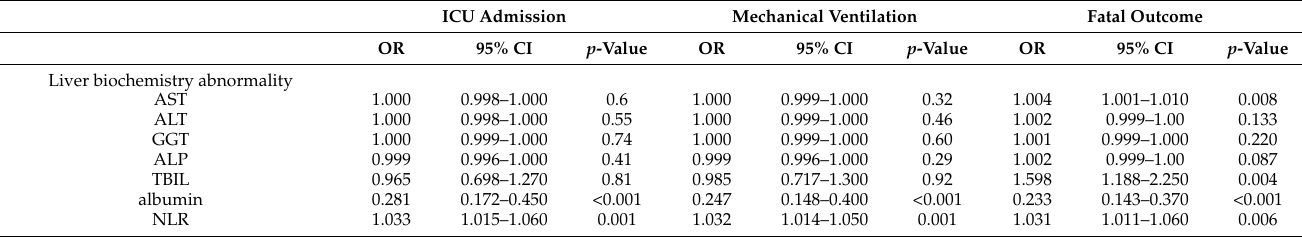
Table 3. The role of liver-related laboratory parameters in models containing potential risk factors and their impact on